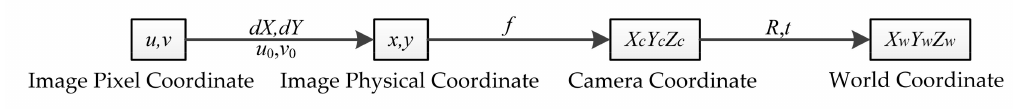
Figure 2. The conversion relationships between the